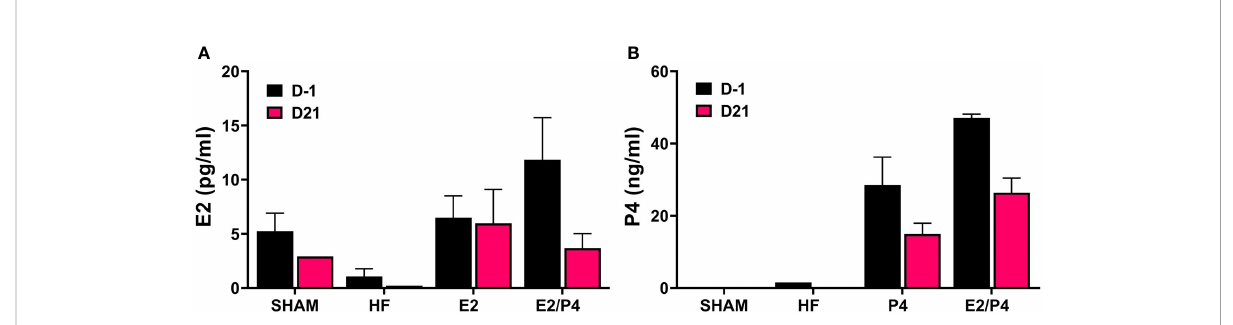
FIGURE 1 Measurement of E2 and P4 from serum. The concentration of 17- b estradiol (A) and progesterone (B) in mouse sera was determined by ELISA or LC MS/MS, respectively as described in the Methods. E2: 17- b estradiol, P4: progesterone, E2/P4: combination of 17- b estradiol and progesterone, SHAM: sera from surgical sham mice treated with DMPA. Data shown represent the average hormone concentration ± standard deviation in pooled sera from 16 mice collected across 2 independent